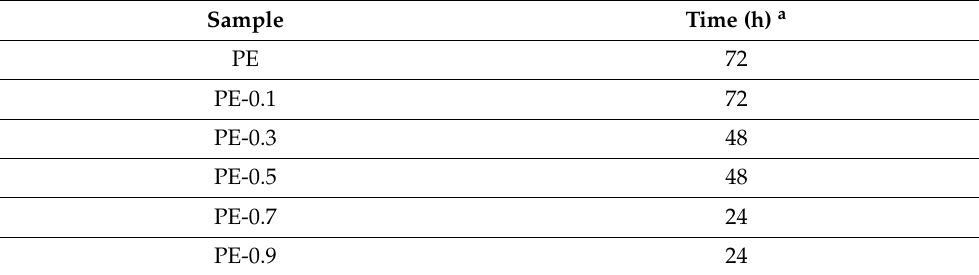
Table 5. The time of infrared detection of carbonyl functional groups in different samples. Sample